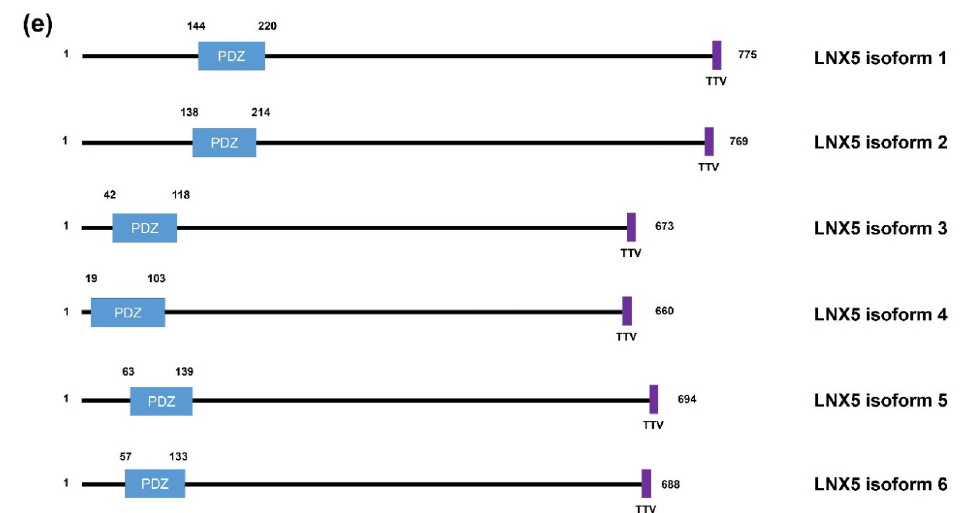
Figure 1. Schematic diagrams of the members of the human LNX family. ( a ) LNX1 has two splicing variants, LNX1p70 and LNX1p80. In contrast to the longer splicing variant, the shorter one does not contain the N-terminal RING domain and the two neighboring Zn finger motifs, while the other known domains following the second Zn finger motif are conserved, which include four PDZ domains and a NUMB-binding motif. Both variants bind to NUMB via the NPAY motif and contain a MAGE-B interacting region. The red dashed bar indicates the point from which the amino acid sequences become identical. ( b ) LNX2 showed the highest similarity with LNX1p80 in terms of primary structure. However, the major difference between LNX1p80 and LNX2 was noted at the region located between the NUMB-binding motif and the point of initiation of the first PDZ domain. While LNX1p80 has a relatively longer sequence that includes the MAGE-B18-interacting motif, LNX2 only has a 21-amino acid-spanning region. ( c ) LNX3 has five splicing variants. The PDZRN4 isoform 1 is the sole variant equipped with an N-terminal RING domain and a juxtaposed Zn finger flanking the C-terminal end of the RING domain. All the variants have two PDZ domains, except the third isoform, which only has one PDZ domain. ( d ) Among LNX4 variants, which include three isoforms, only the PDZRN4 isoform 1 has an N-terminal RING domain and a SINA-like motif. Similar to LNX3, the variants have two PDZ domains; the third isoform is an exception as it has only one relatively short PDZ domain identical to that in the PDZRN4 isoform 3. ( e ) LNX5 has six splicing variants. All variants have a single PDZ without any recognizable domains. The last three single letter amino acid codes represent the class I PDZ-binding motif (S/T-X-V/I/L). The scale bar on the top indicates the approximate length in terms of the number of amino acids for the comparison of individual proteins. ZF; Zn finger motif, RING; really interesting new gene, MAGE; melanoma-associated antigen, PDZ; PSD95-DLGA-ZO-1, SINA; seven in absentia, TRAF; tumor necrosis factor receptor (TNF-R)-associated factor. The schematic illustration of the alignment of the LNX/PDZRN domains are derived from the deduced amino acid sequence information retrieved from GenBank; the corresponding accession numbers have been provided: LNX1p80 (NP_001119800.1), LNX1p70 (NP_116011.2), LNX2 (NP_699202.1), PDZRN3 isoform 1 (NP_055824.1), PDZRN3 isoform 2